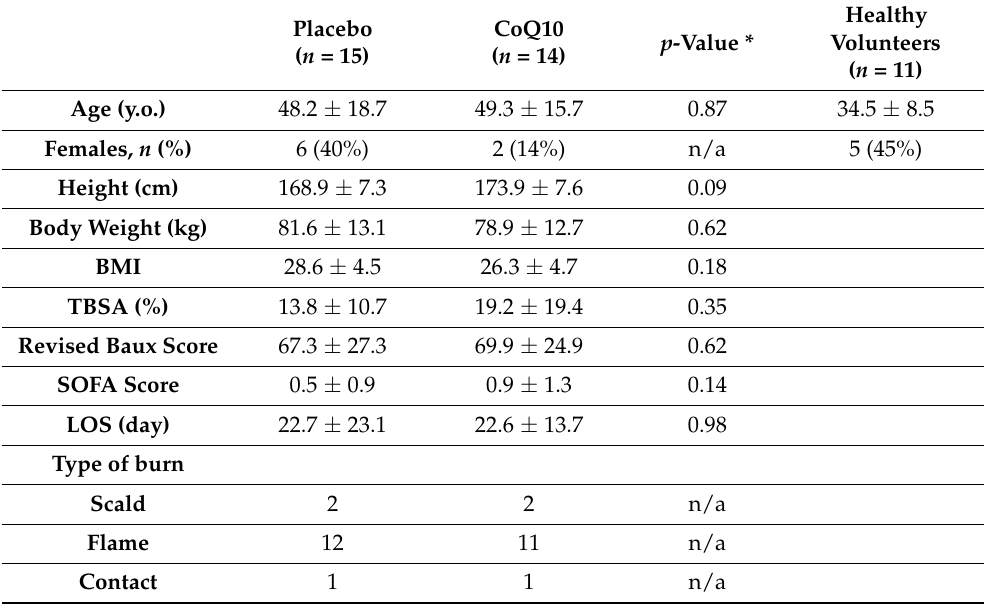
Table 1. Baseline characteristics of burn